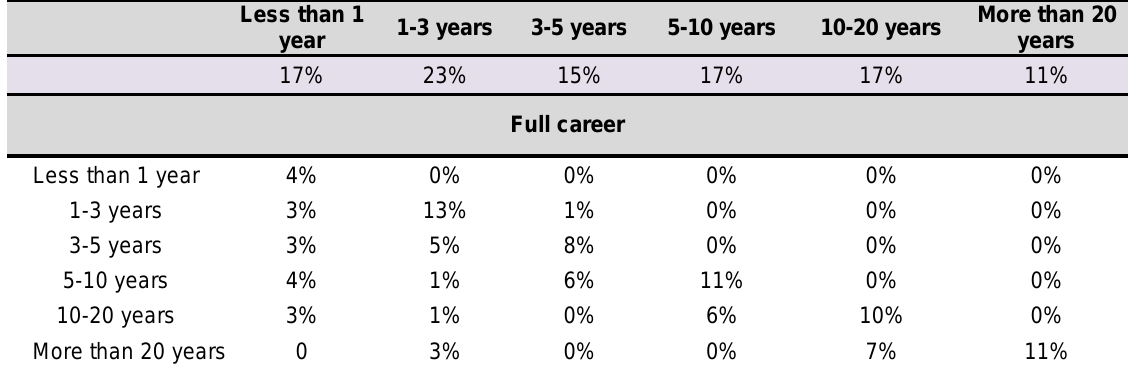
Table 3 - The length of career and current place of employment